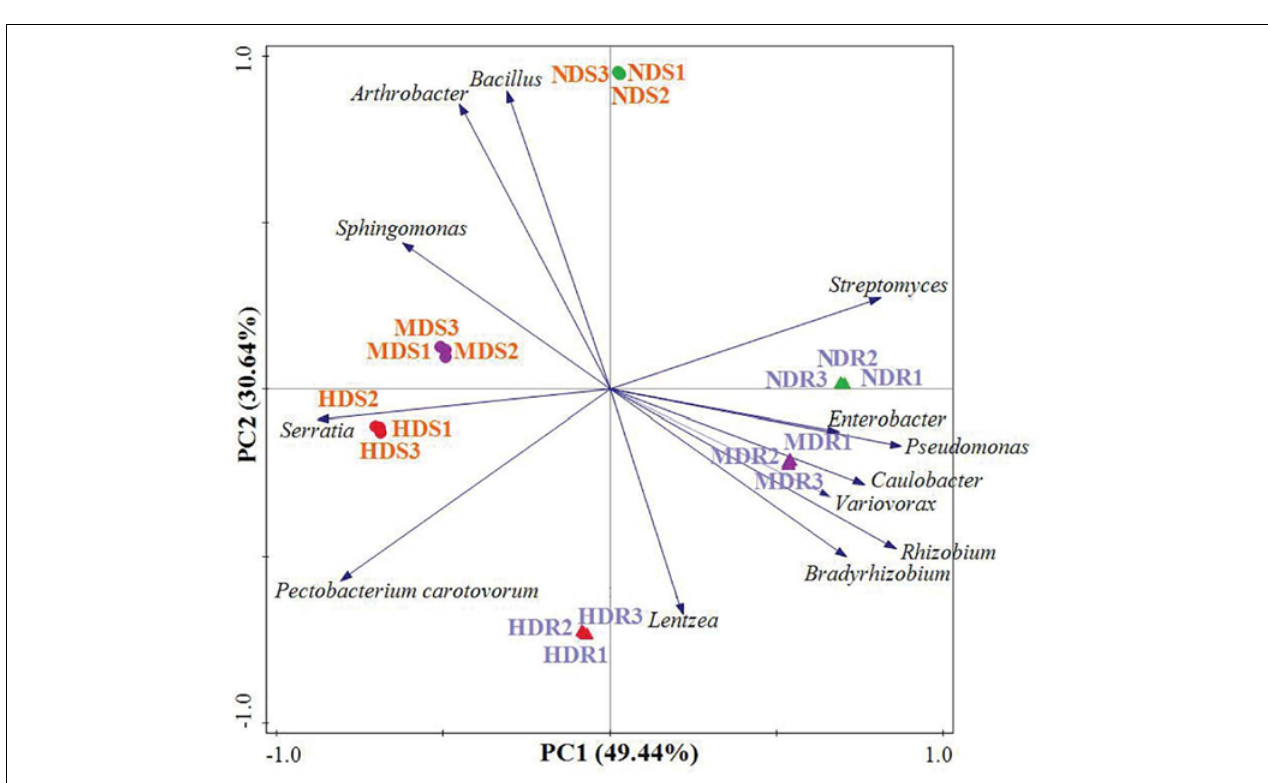
FIGURE 5 | Principal component analysis of the dominant and pathogenic bacterial operational taxonomic units (genera) recovered from the root and soil samples in different konjac growing sites. NDS, MDS, and HDS represent the soil samples from the non-diseased, moderately diseased, and highly diseased sites, respectively. NDR, MDR, and HDR represent the plant root samples from the non-diseased, moderately diseased, and highly diseased sites, respectively.